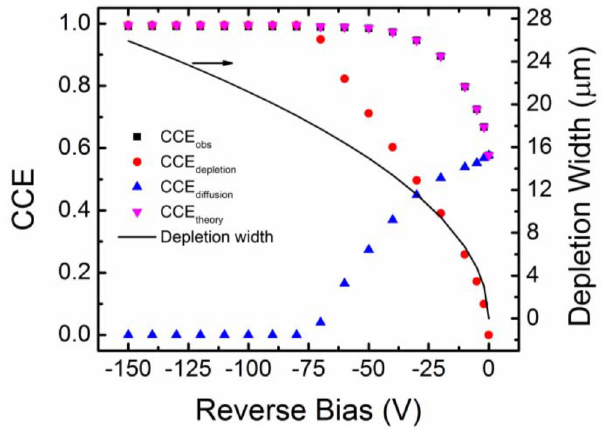
Figure 8. Variation of CCE obs and CCE theory with reverse bias voltage for an n-type Ni / 4H-SiC (n-S20) SBD. The contributions of CCE depletion and CCE dif fusion to the total CCE obs are also plotted. The solid line shows the variation of depletion width with bias.